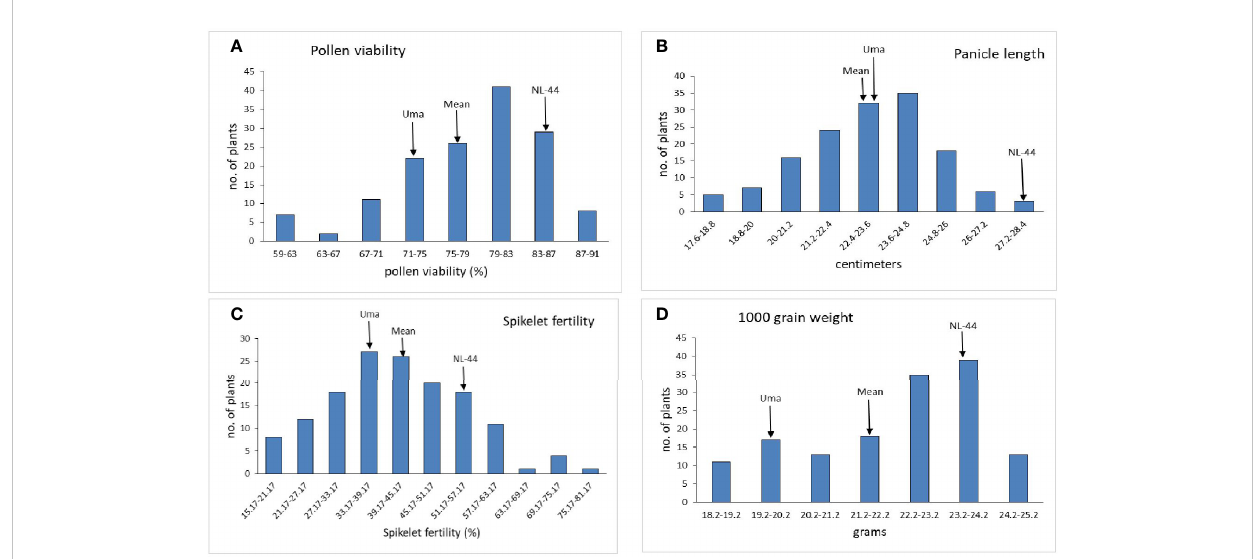
FIGURE 4 Frequency distribution of pollen viability (A) , panicle length (B) , spikelet fertility (C) , and 1,000 grain weight (D) under the effect of high temperature stress among the F 2